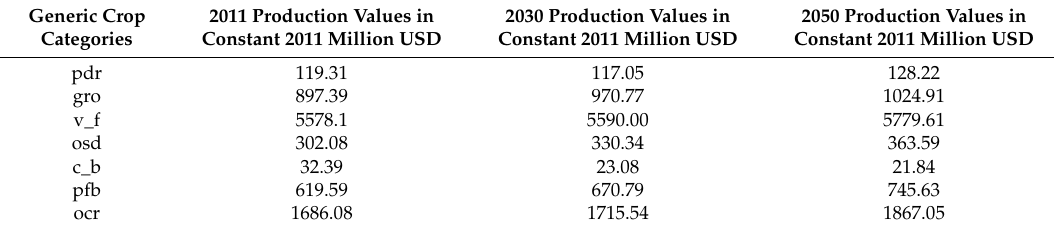
Table 2. Crop production market values in 2011, 2030 and 2050.